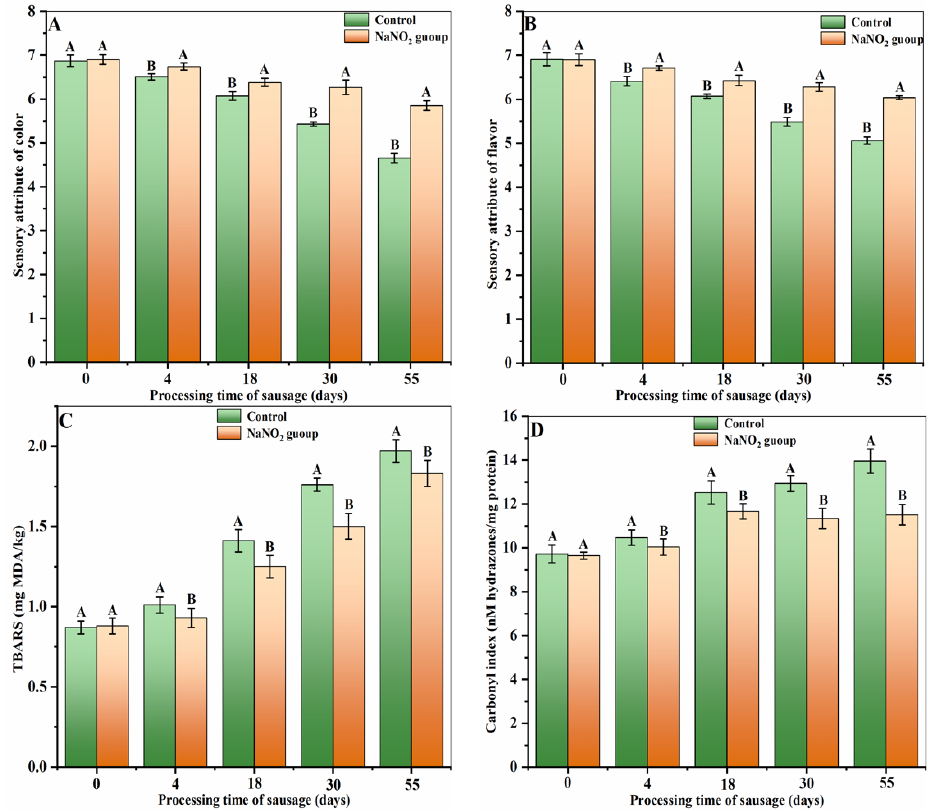
Figure 1. Dynamic color changes ( A ), flavor ( B ), TBARS ( C ), and carbonyl index ( D ). Different uppercase letters in a column indicate significant differences among treatments during storage time (days) for each treatment ( p < 0.05).